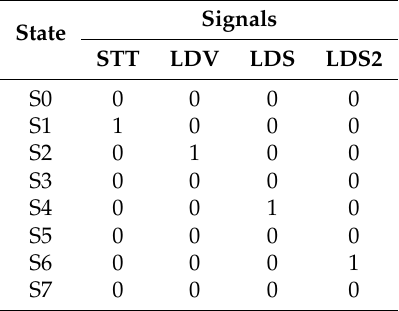
Table A2. State machine signals of the discrete trapezoidal profile.